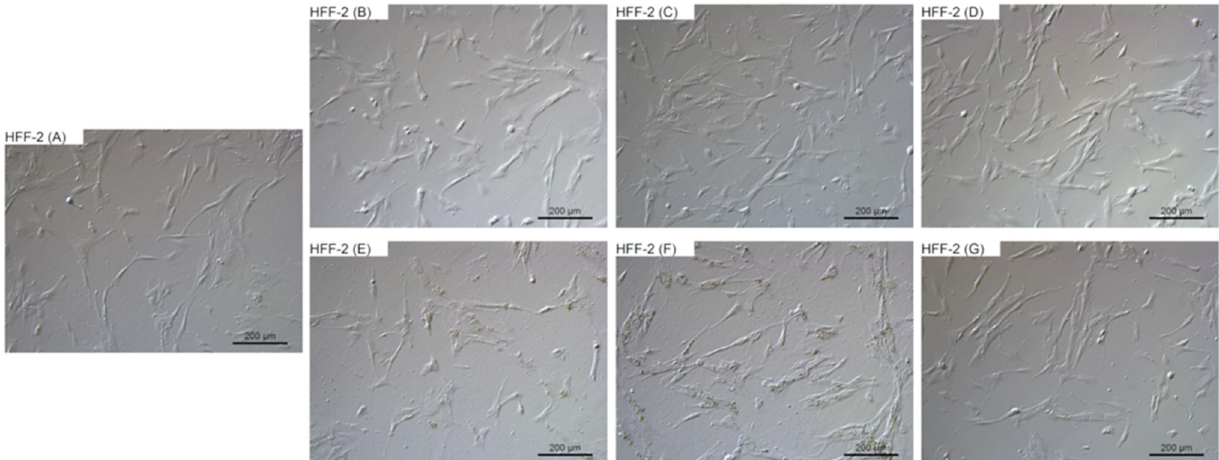
Figure 8. Morphological characterization of the HFFF-2 human fibroblast cell line. The cells were treated with metallic NPs at a concentration of 1 mg/L and carbon-based nanomaterials at a concentration of 10 mg/L. The incubation period lasted for 24 h. ( A ) control were treated with ultrapure water, ( B ) cells were treated with Ag, ( C ) cells were treated with Au, ( D ) cells were treated with Pt, ( E ) cells were treated with GO, ( F ) cells were treated with ND, and ( G ) cells were treated with C 60 (OH) 40 .